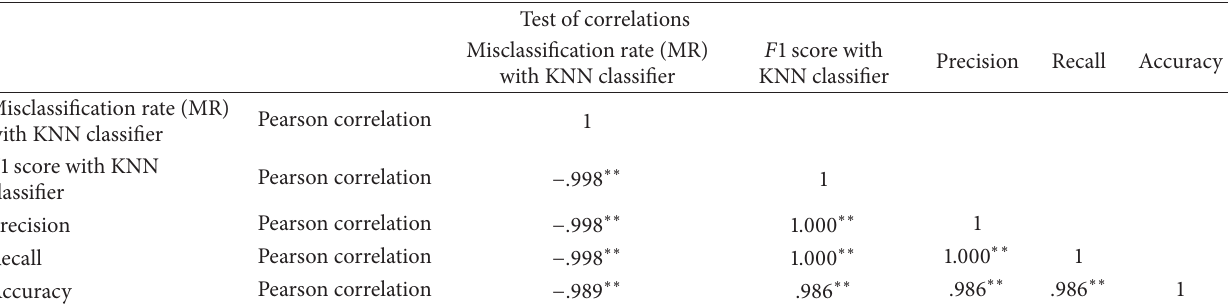
Table 6: Test of correlation among different evaluation metrics.